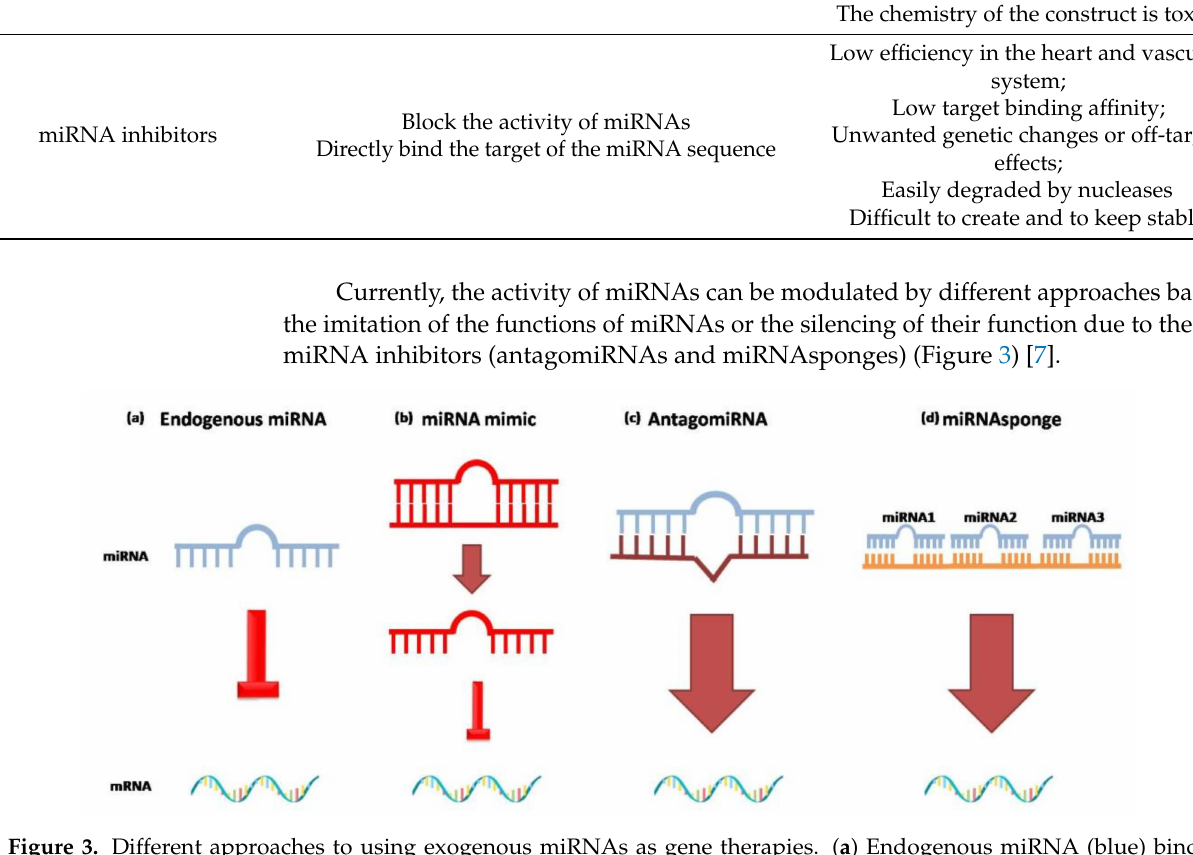
Figure 3. Different approaches to using exogenous miRNAs as gene therapies. ( a ) Endogenous miRNA (blue) binds to the seed sequence present in the 3 (cid:48) -UTR of the mRNA target; ( b ) representation of miRNA mimic (red), a synthetic double-stranded RNA molecule. The double-stranded structure mimics the endogenous miRNA*duplex that binds RISC to inhibit translation of the mRNA target. ( c ) AntagomiRNA (brown) synthetic miRNA complementary to the target miRNA that has to be inhibited. ( d ) miRNAsponge(orange) synthetic oligonucleotide containing several seed sequences for different multiple